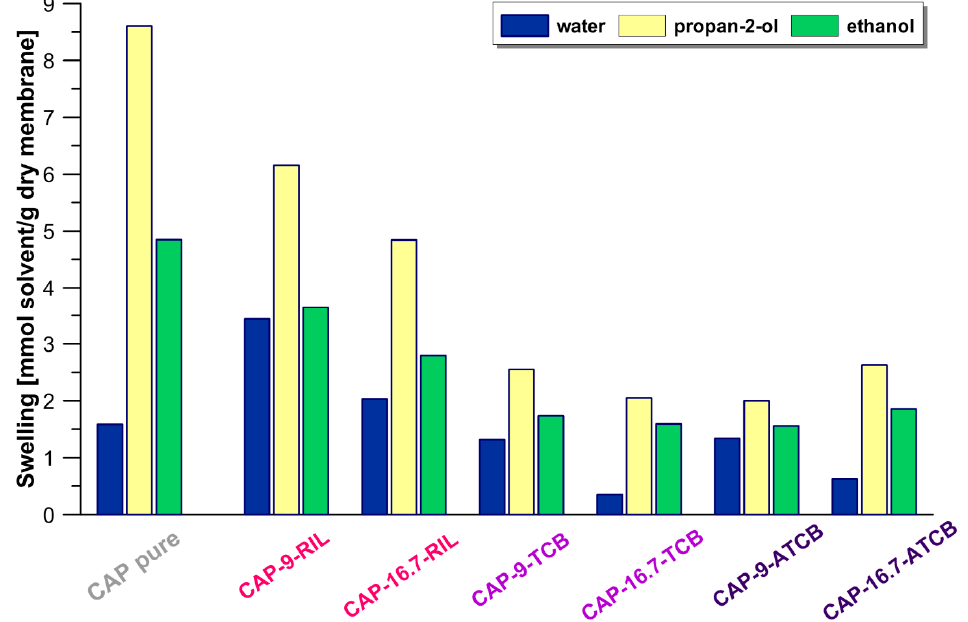
Figure 10. The swelling at equilibrium of pure CAP membranes and membranes doped by RIL, TBC and ATBC in contact with water, ethanol, and